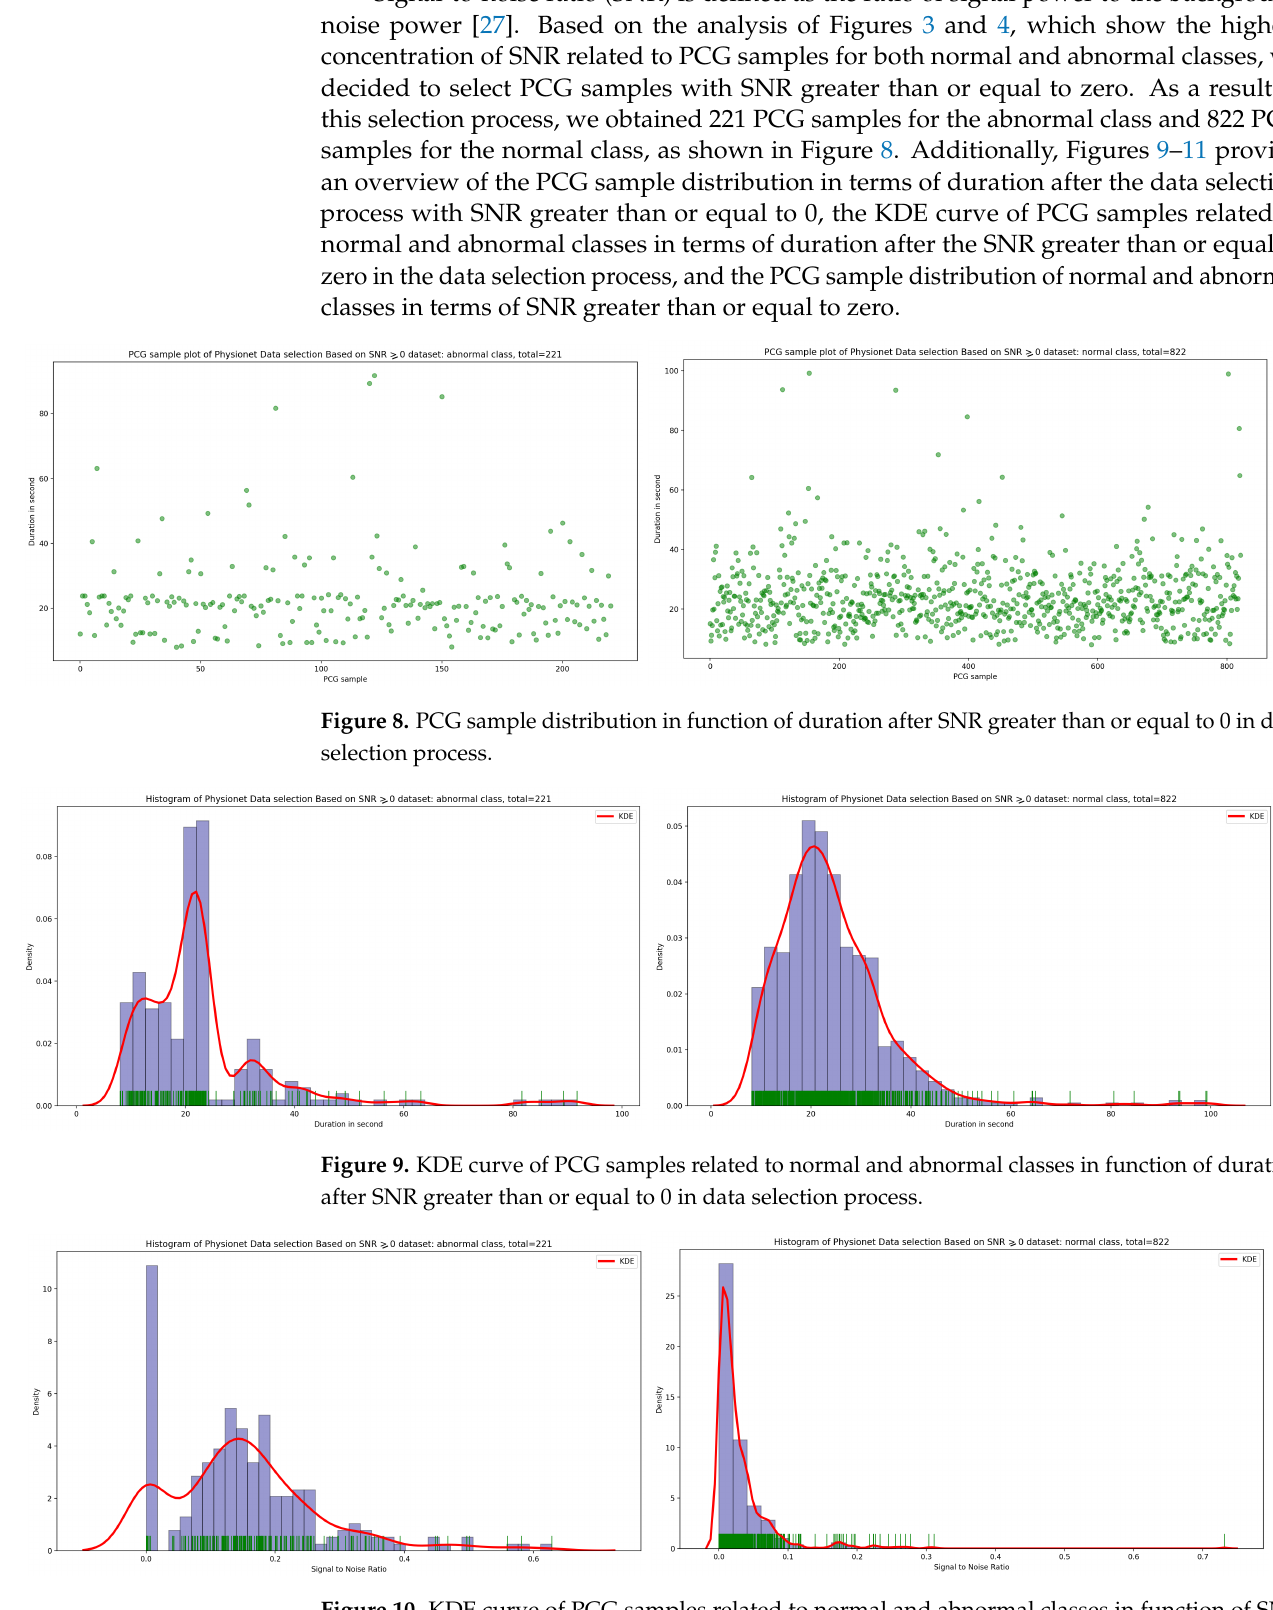
Figure 10. KDE curve of PCG samples related to normal and abnormal classes in function of SNR greater than or equal to